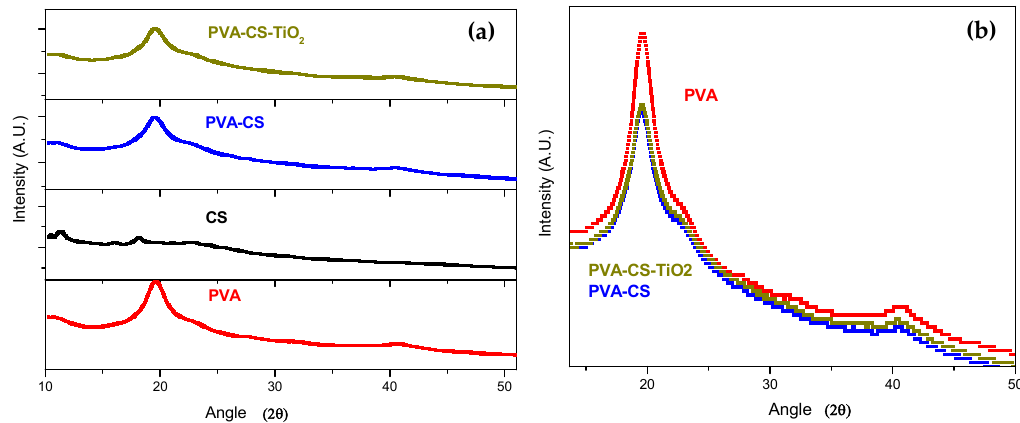
Figure 6. ( a ) X-ray diffraction spectra of precursors and the PVA/CS system (1000 ppm TiO 2 ). ( b ) Qualitative comparison of the diffraction peaks.